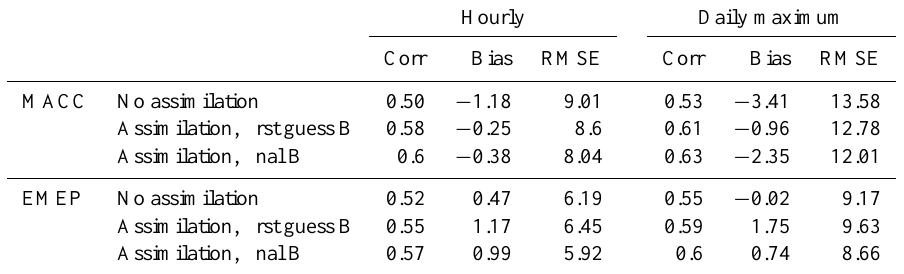
Table 4. Comparison of performance indicators for NO 2 in the 2012 reanalysis. The station sets MACC and EMEP and assimilation options are as in Table